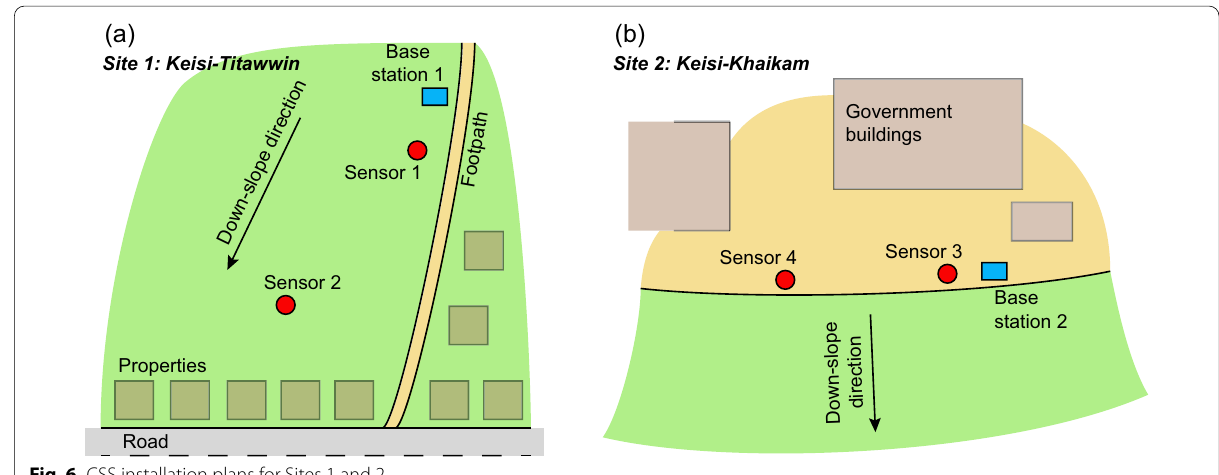
Fig. 6 CSS installation plans for Sites 1 and